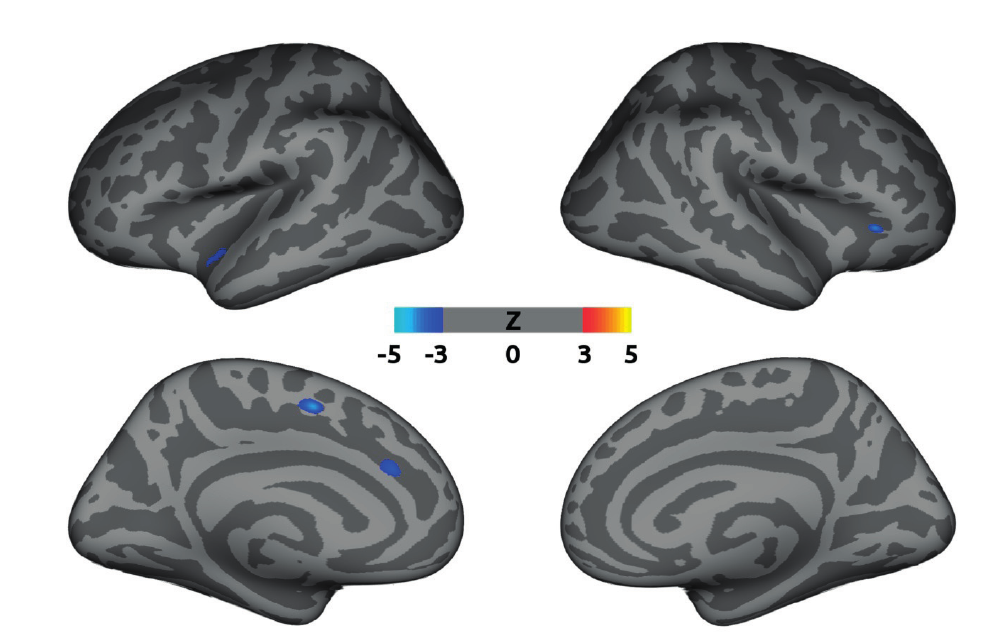
Fig. 2. Significant vertex-wise differences in cortical thickness FOG and FOG+. Colour overlay shows vertices of significant average difference in cortical thickness (represented by Z score, thresholded at P < 0.001, uncorrected) on top of an average inflated three-dimensional cortical surface reconstruction. The cold colours represent greater atrophy in FOG+ group, whereas warm colours represent greater atrophy in FOG- group. Left columns show the left hemisphere, right columns show the right